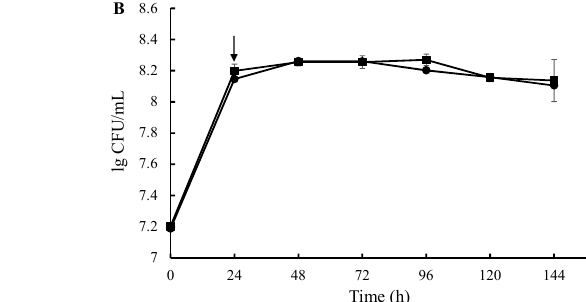
Figure 3. Cholesterol conversion by S. hirsuta in a rich (GSMY) medium. ( A ) Identification under UV light (254 nm). ( B ) TLC-plate staining with a MnCl 2 solution followed by identification under UV light (365 nm). The sample volume to the spot was 50 µL ( A , B ). ( C ) Kinetics of steroid products accumulation and cholesterol utilization (HPLC data). Designations: 1, cholesterol; 2, 26-hydroxycholesterol; 3, 3 β -hydroxycholest-5-en-26-oic acid; 4, cholest-4-en-3-one; 5, 26-hydroxycholest-4-en-3-one; 6, 3-oxo-cholest-4-en-26-oic acid; 7, 3-oxo-cholesta-1,4-dien-26-oic acid; 8, cholesta-1,4-dien-3-one.